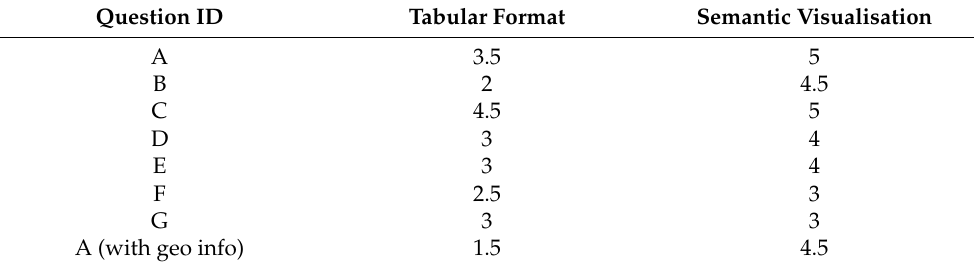
Table 1. Evaluation